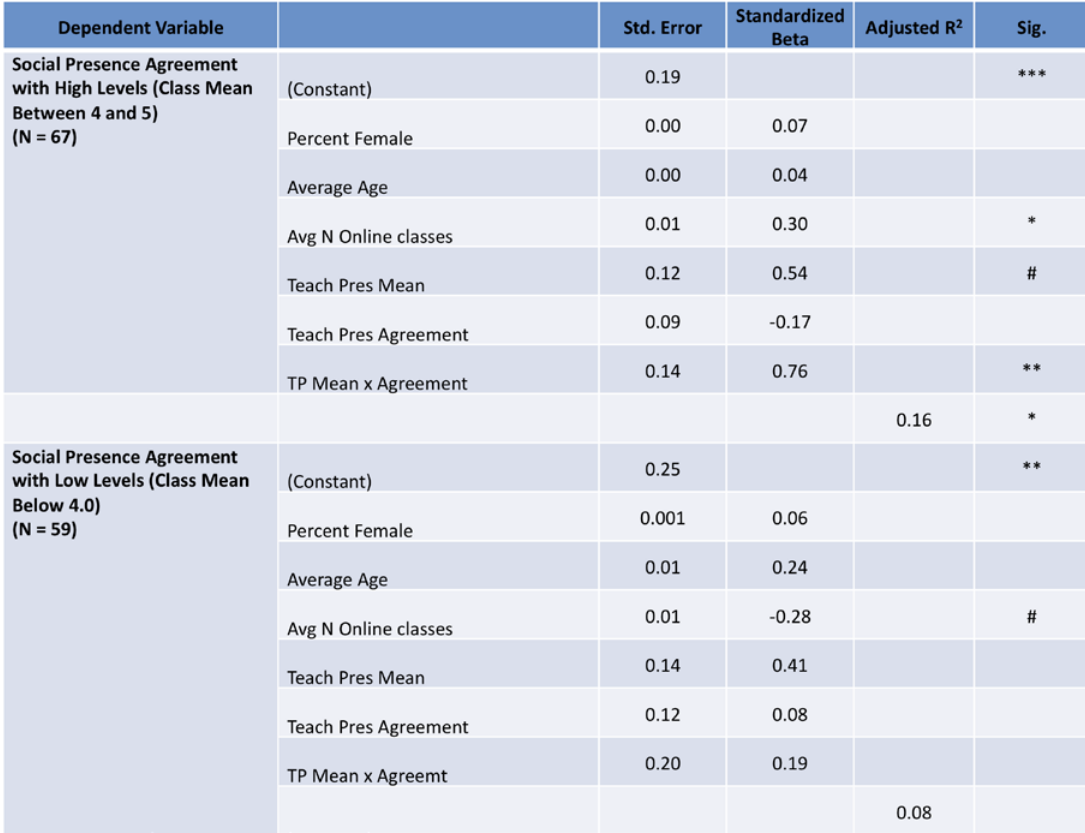
Effect of Class Teaching Presence on Agreement About Social